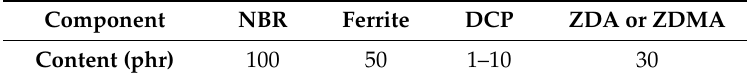
Table 3. Composition of rubber compounds with different amount of dicumyl peroxide.